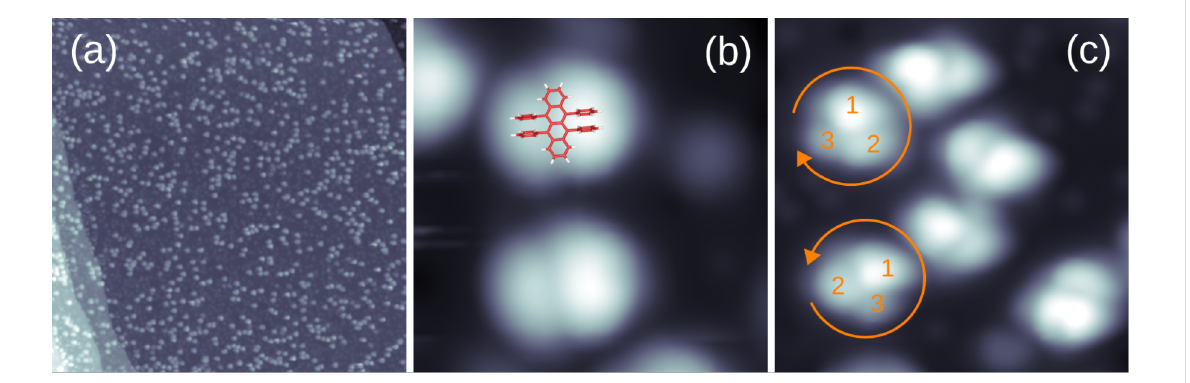
Figure 2: (a) STM image of C 42 H 28 molecules on Pt(111) (bias voltage: 1 V, tunneling current: 100 pA, size: 150 × 150 nm 2 ). (b) Close-up view of C 42 H 28 with twisted configuration of the backbone 1 V, 100 pA, 5 × 5 nm 2 ). The attached molecule sketch is to scale. (c) Close-up view of C 42 H 28 with twisted and tilted configuration of the backbone (1 V, 100 pA, 7.1 × 7.1 nm 2 ). 1 , 2 , and 3 number the brightest to the dimmest lobe and reveal the two rotational